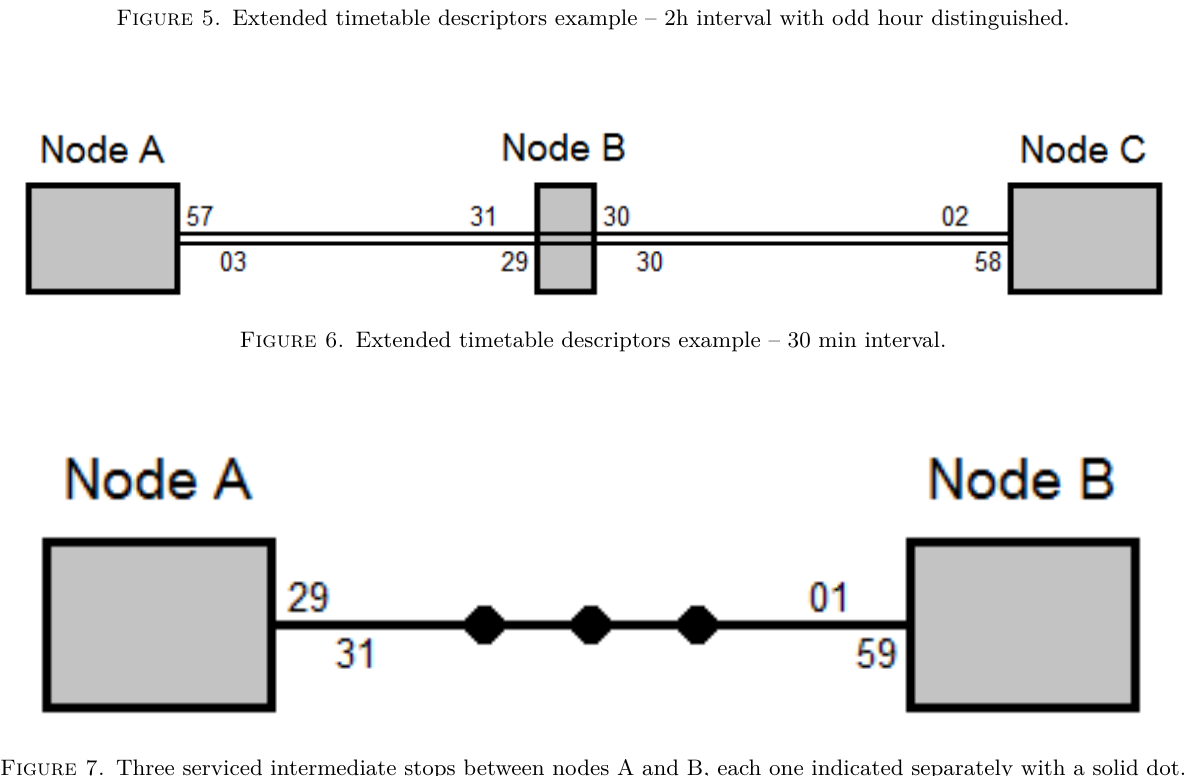
Figure 7. Three serviced intermediate stops between nodes A and B, each one indicated separately with a solid